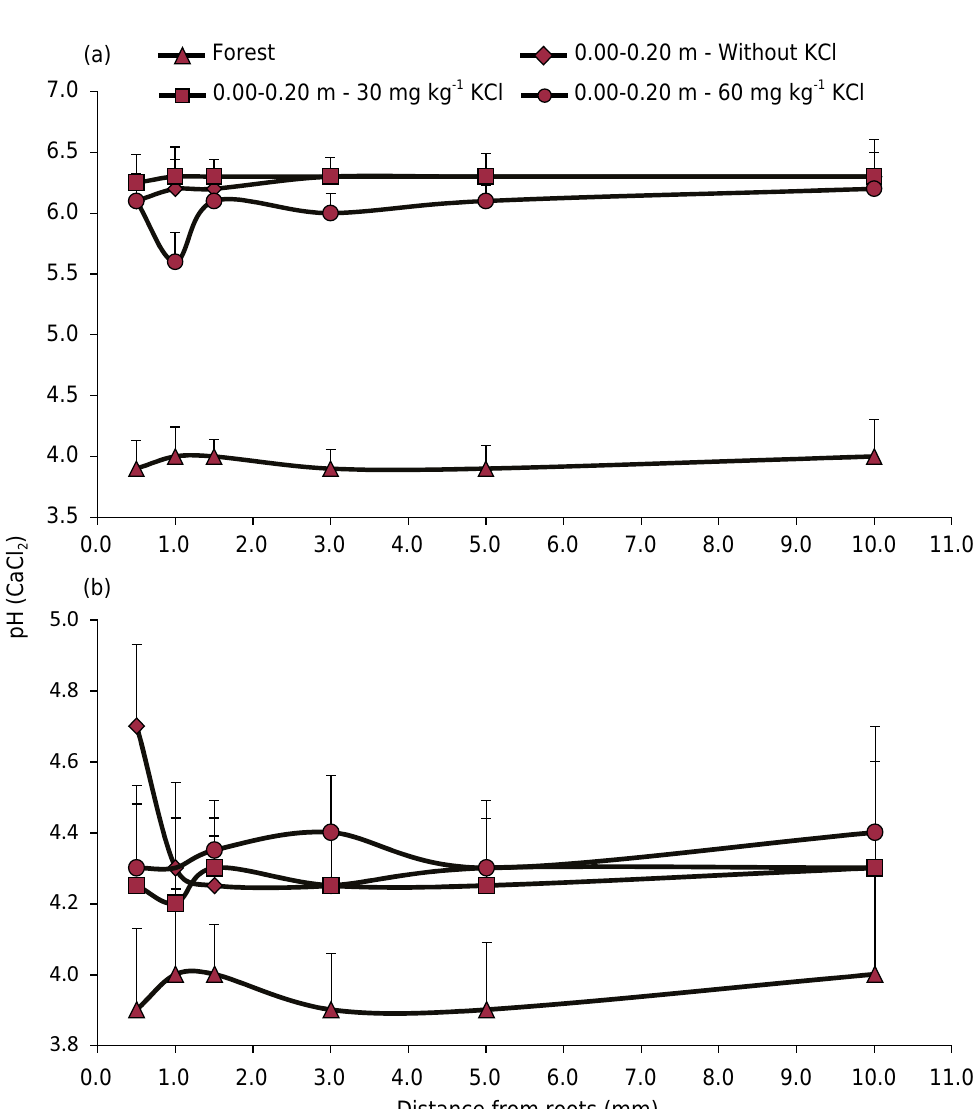
Figure 2. Soil pH(CaCl 2 ) as affected by treatments and K fertilization. Vertical bars show the LSD (p<0.05), and compare treatments within each distance from the ruzigrass